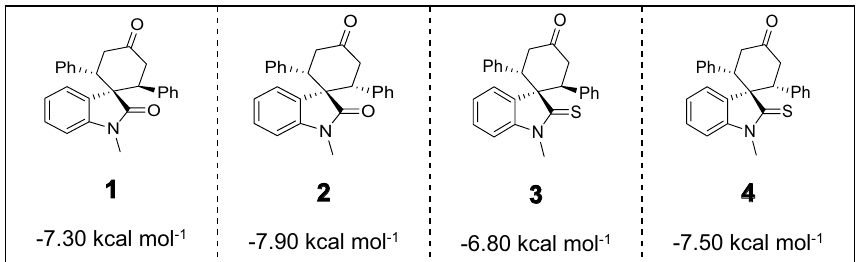
Table 1. Calculated binding energies (kcal mol −1 ) of trans/cis -spirocyclic (thio)oxindoles with OPRT domain of LdUMPS.